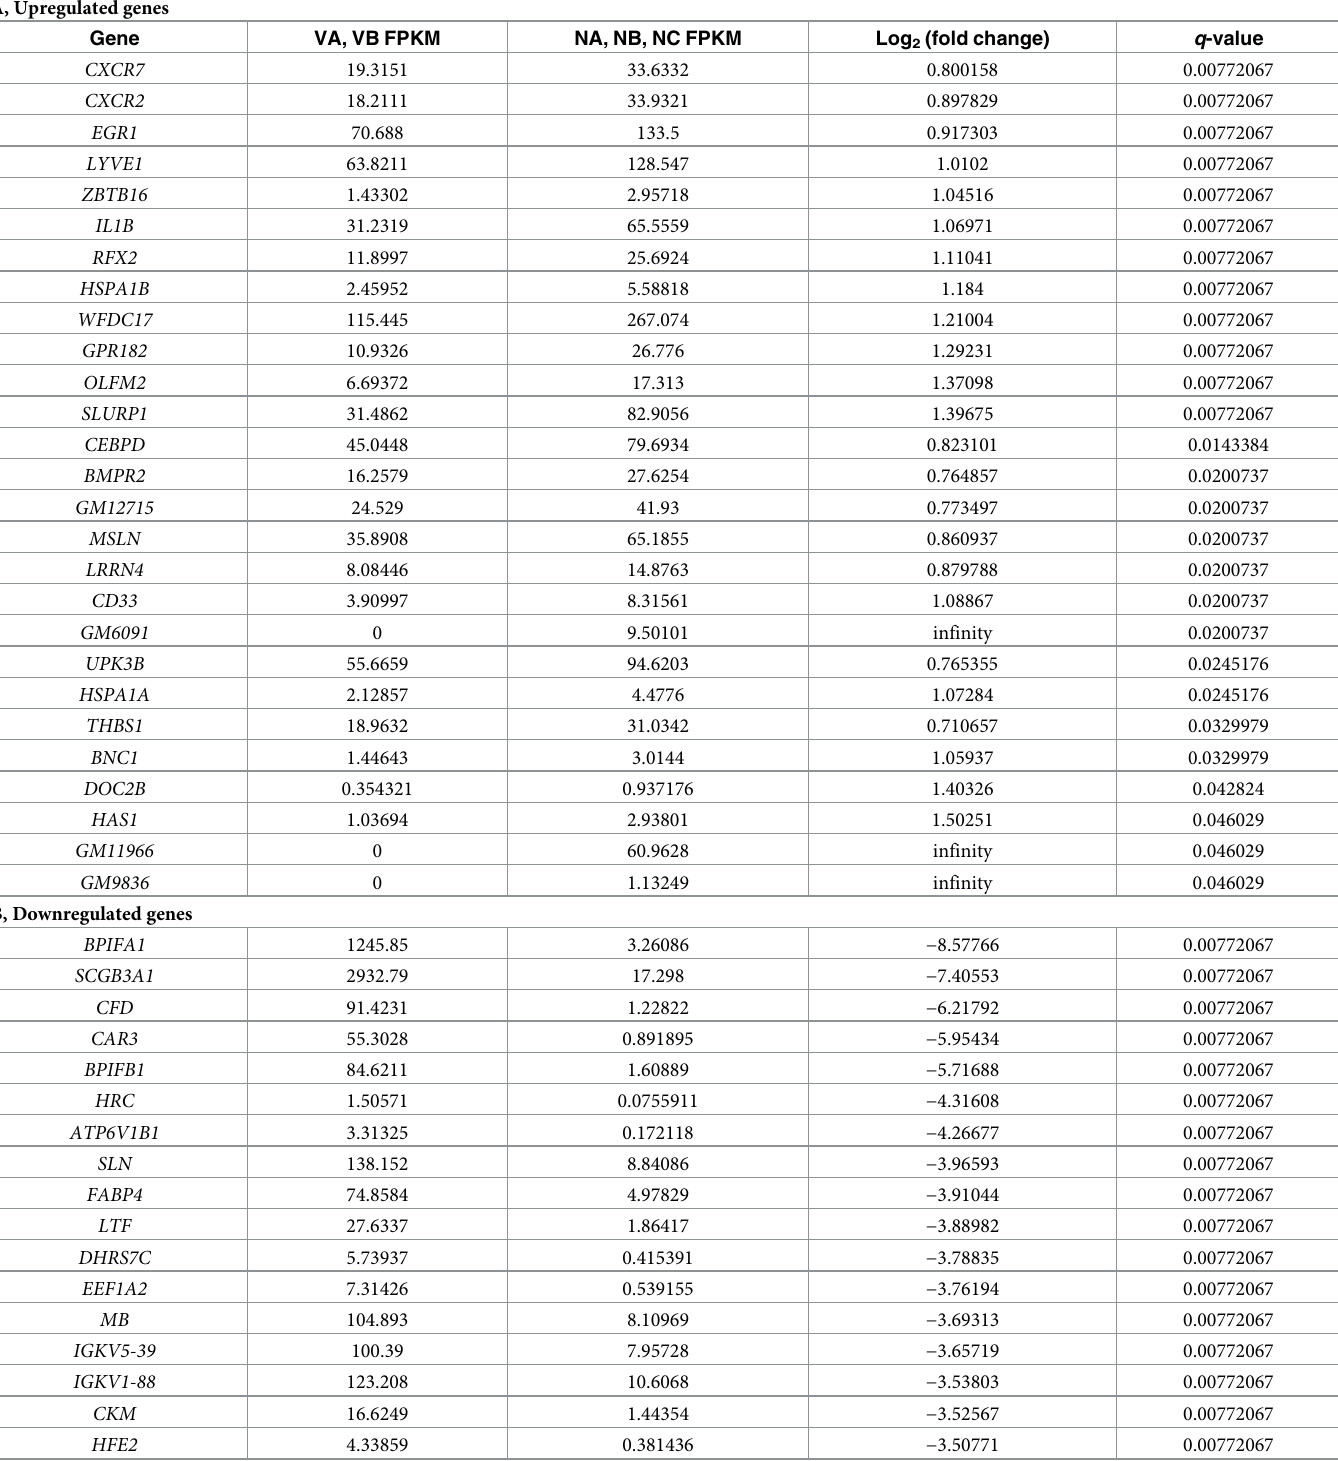
Table 1. Genes with significantly different expression in the nintedanib-treated cluster (NA, NB, and NC) compared with that in the vehicle-treated cluster (VA and VB). A, Upregulated